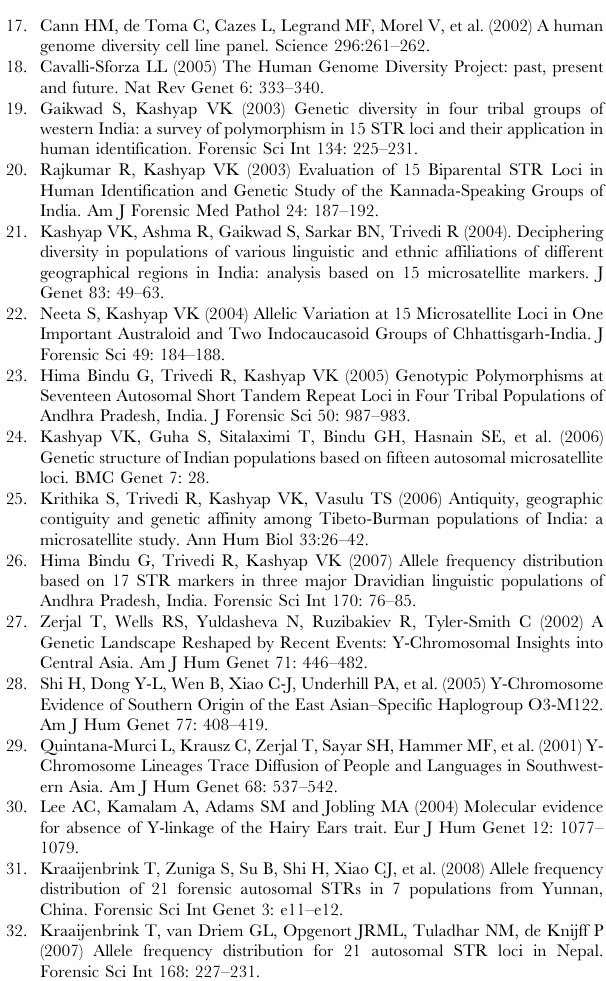
Table S1 Overview of all reference populations sup- plied for this study. Table S2 Overview of Nepalese populations pooled for or excluded from statistical analyses. Table S3 Summary statistics.